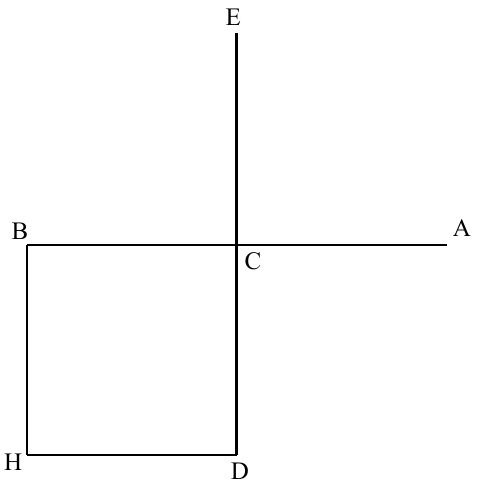
Figure 4. Equilibrium of a beam in the space. Redrawn from [19], p.